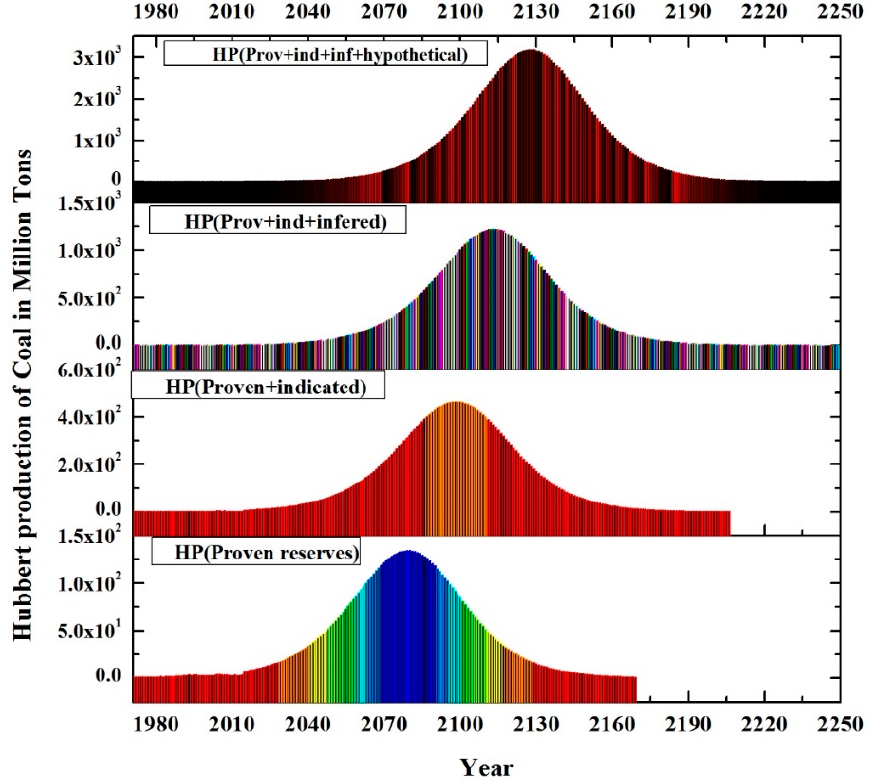
Figure 11. Coal Hubbert production peaks under multiple probabilities.